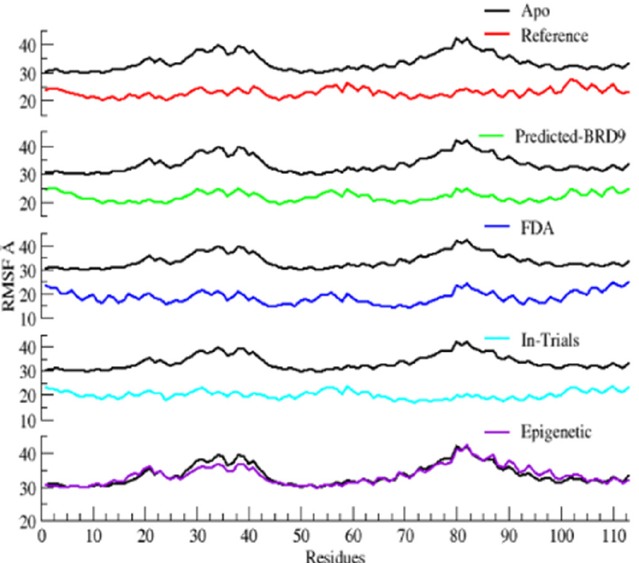
Figure 12. RMSF plots for BRD9 protein with Apo (black) and reference compound (red); ZINC28232750 (blue); ZINC2036848 (cyan); ZINC95589781 (purple).